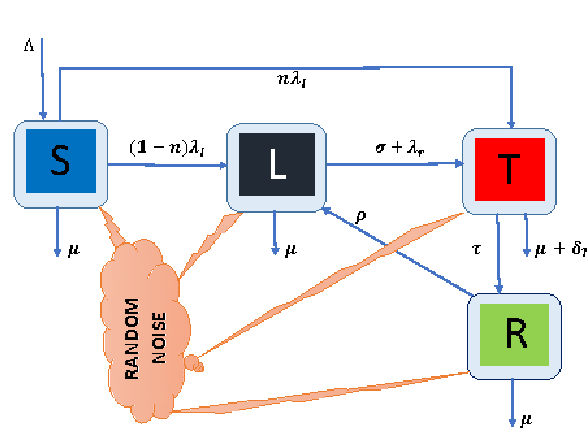
Fig. 1. Diagram of the stochastic model of TB with